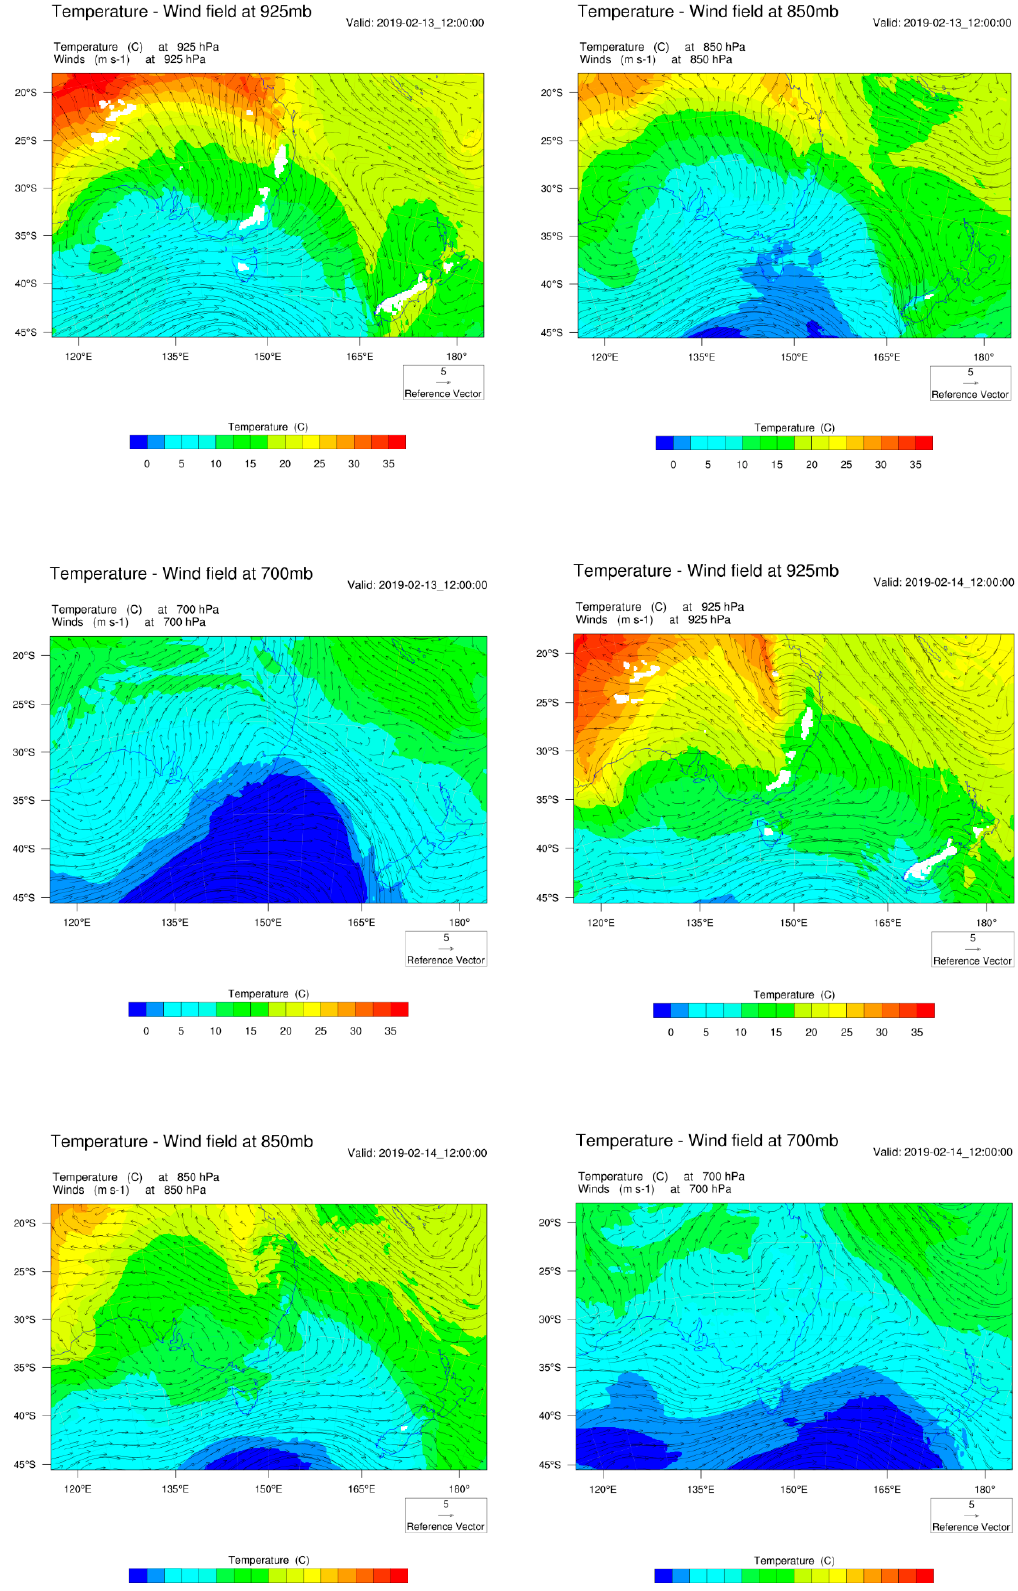
Figure A2. Temperature and wind field at 950 mb, 850 mb and 700 mb on 13 February 2019 12:00 UTC and 14 February 2019 12:00